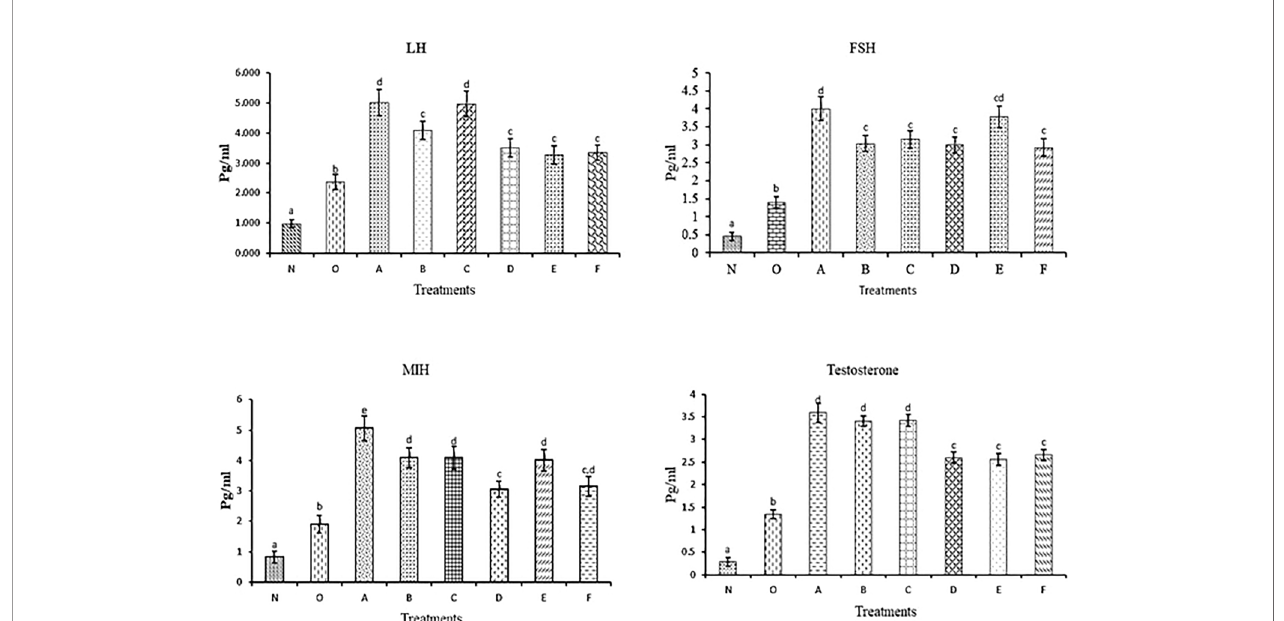
FIGURE 9 | Hormonal levels in blood serum collected at different time points in a different group of treatments. The different letters used indicates signi fi cant differences and superscripts indicate the non-signi fi cant difference in hormonal levels. Data were expressed as mean ±